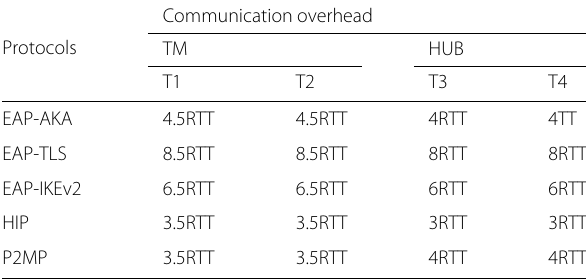
Table 7 Comparison of protocols by round trip time Protocols